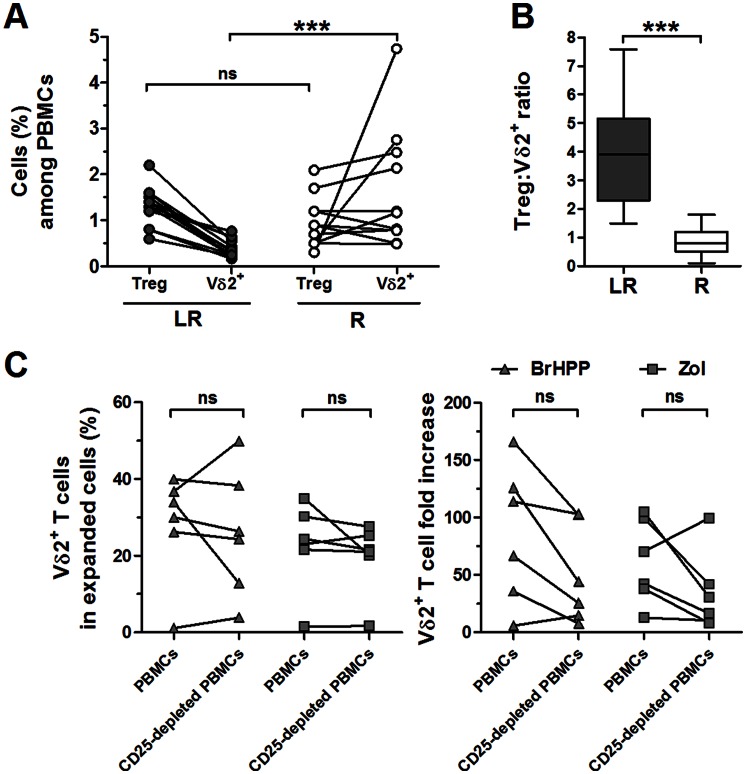
An imbalanced ratio of Tregs and Vγ9Vδ2 cells in ex vivo LR EOC PBMCs.
A) CD4+CD25highFoxP3high cell (Treg) frequencies and corresponding Vδ2+CD3+ cell frequencies in ex vivo LR (n = 13) and R (n = 11) PBMCs. B) The ratios of Tregs (%) to Vδ2+CD3+ cells (%) (Treg:Vδ2+ ratio) among PBMCs in the LR and R groups. C) LR PBMCs from EOC patients (n = 6) were stimulated with BrHPP (▴) or Zol (▪) and IL-2 before and after the depletion of CD25+ cells; the proliferation of Vδ2+CD3+ cells was analyzed on day 7. Vδ2+CD3+ cell frequencies among expanded cells (left panel) and Vδ2+CD3+ cell fold increases (right panel) are shown.